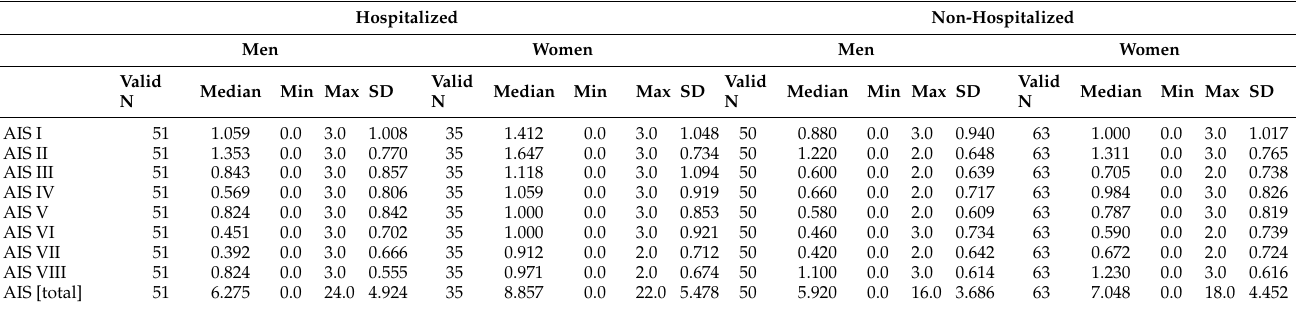
Figure 11. Non-hospitalized patient results in the AIS — overall score (Mann – Whitney U test). The descriptive statistics for all of the AIS questions, separately, and the overall results are presented below for both hospitalized and non-hospitalized patients divided by gender (Table 4). Table 4. Basic characteristics of the results obtained in the AIS for both hospitalized and non- hospitalized patients divided by gender. Hospitalized Non-Hospitalized Men Women Men